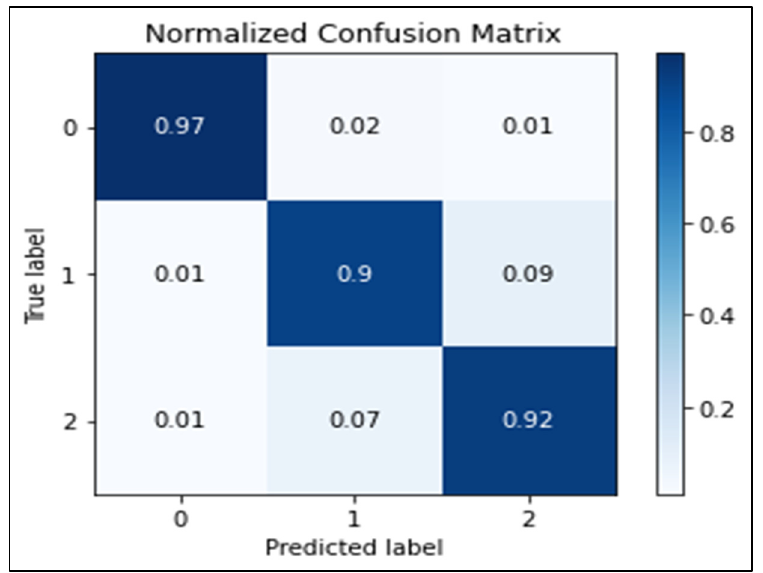
Big Data Cogn. Comput. 2023 , 7 , x FOR PEER REVIEW 24 of 30